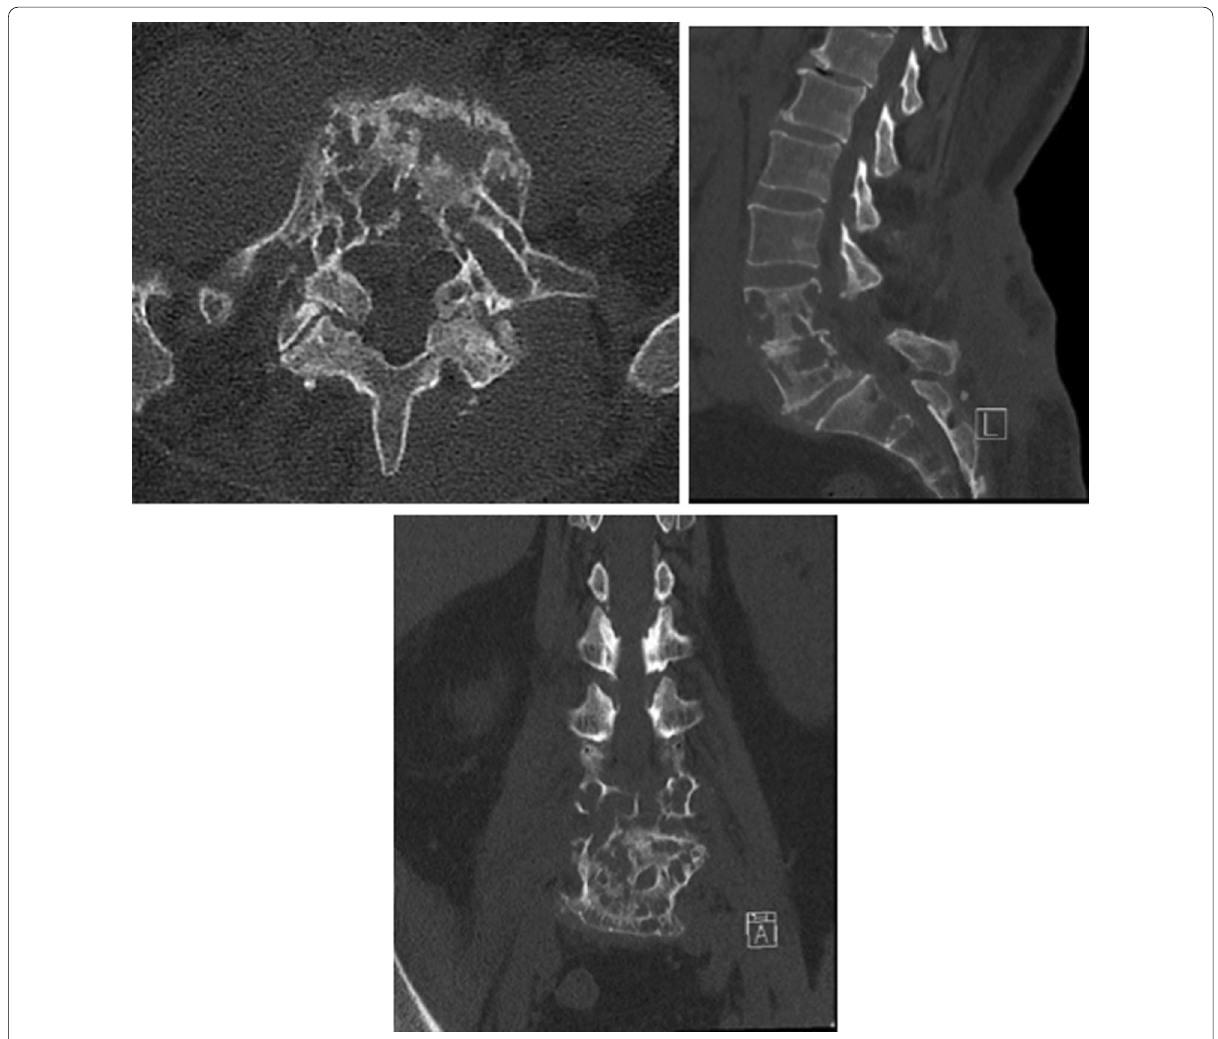
Fig. 4 Postoperative lumbo-sacral spinal CT—axial, sagittal, and coronal